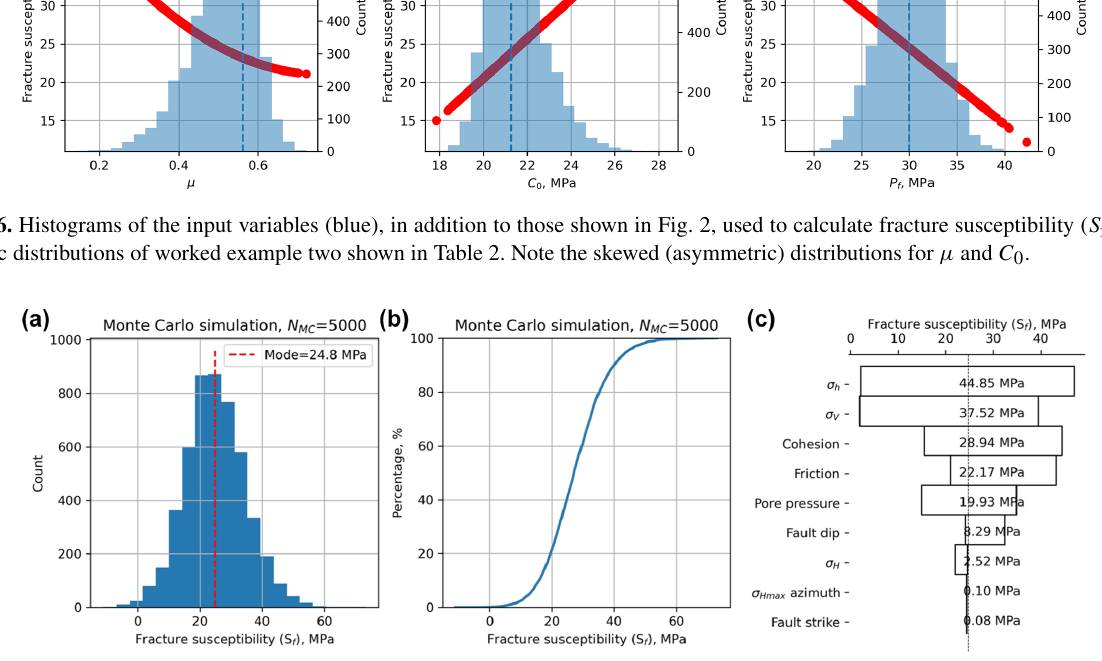
Figure 7. Output from Monte Carlo simulations ( N MC = 5000) of fracture susceptibility ( S f ) calculated using a quadratic response surface from synthetic input data in worked example two. (a) Histogram of calculated S f , showing a quasi-normal distribution with a mode of 21.7MPa. (b) Cumulative distribution function (CDF) of calculated fracture susceptibility, showing the range in values from just less than 0 to about 60MPa. (c) Tornado plot of relative sensitivities of the input variables used to calculate fracture susceptibility ( S f